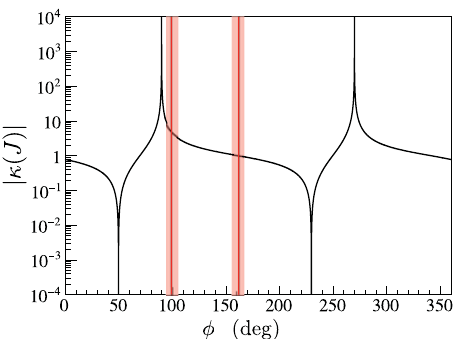
Figure 9. Value of | κ ( J ) | as a function of φ . Each solid line and shaded area shows the central value of a solution for φ and its 1 σ uncertainty, respectively.